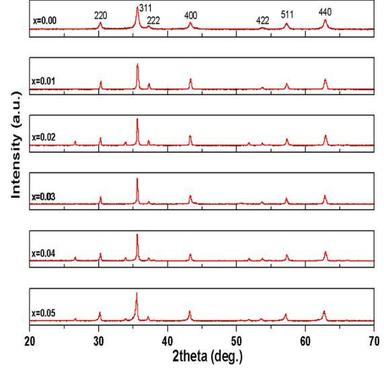
(a) XRD powder patterns and (b) unit cell structure of NCZFe2- 4xSn3xO4 NSFs.